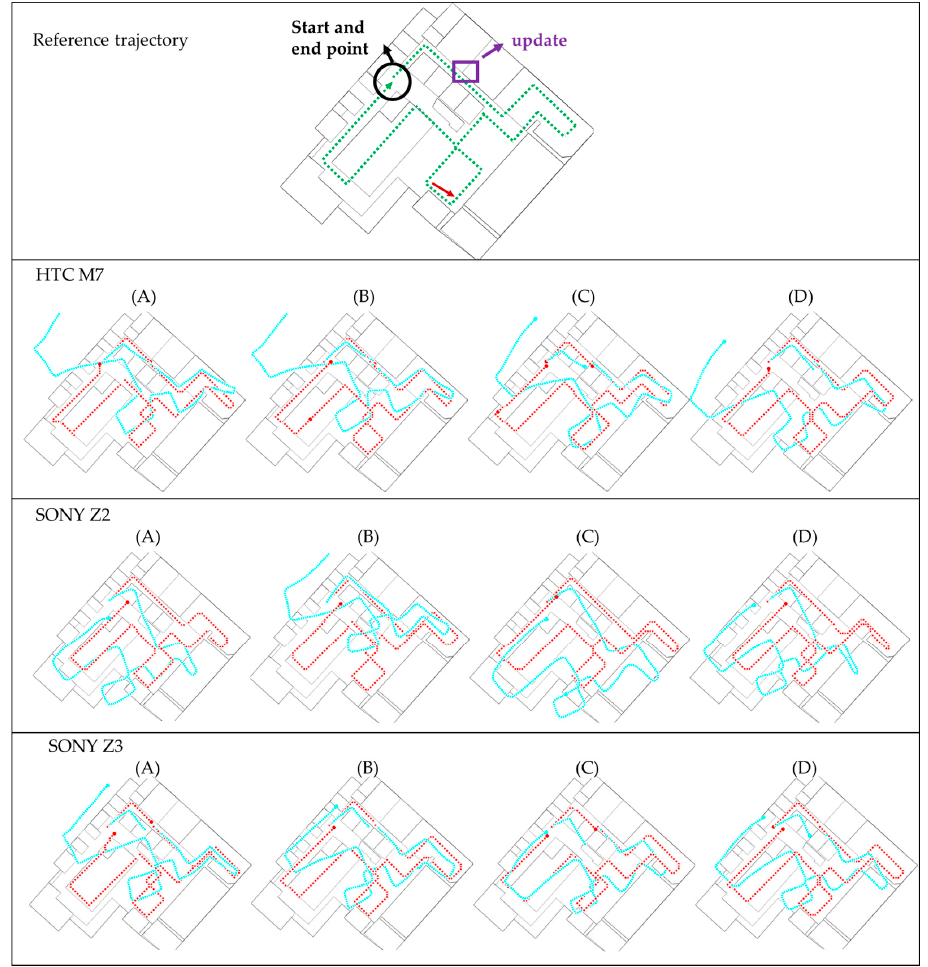
Figure 14. The experimental trajectories at the hall of enterprise.